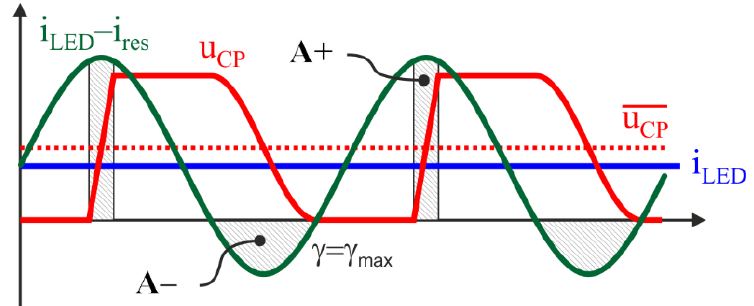
Figure 4. Variation of the angles α , β , asin(q) , γ and γ max in degrees as a function of q for different ĸ values: ( a ) ĸ equal to 1.2; ( b ) ĸ equal to 1.6; ( c ) ĸ equal to 2.0.